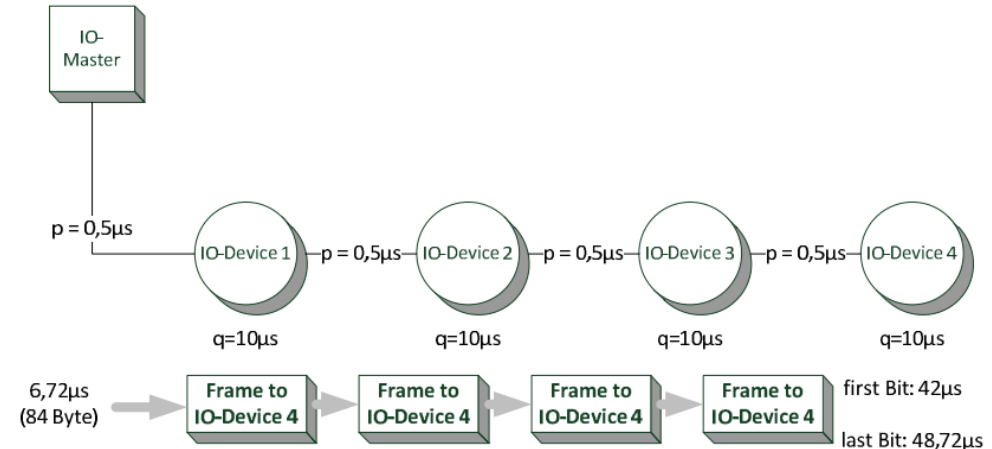
Fig. 4. Calculation of data transmission